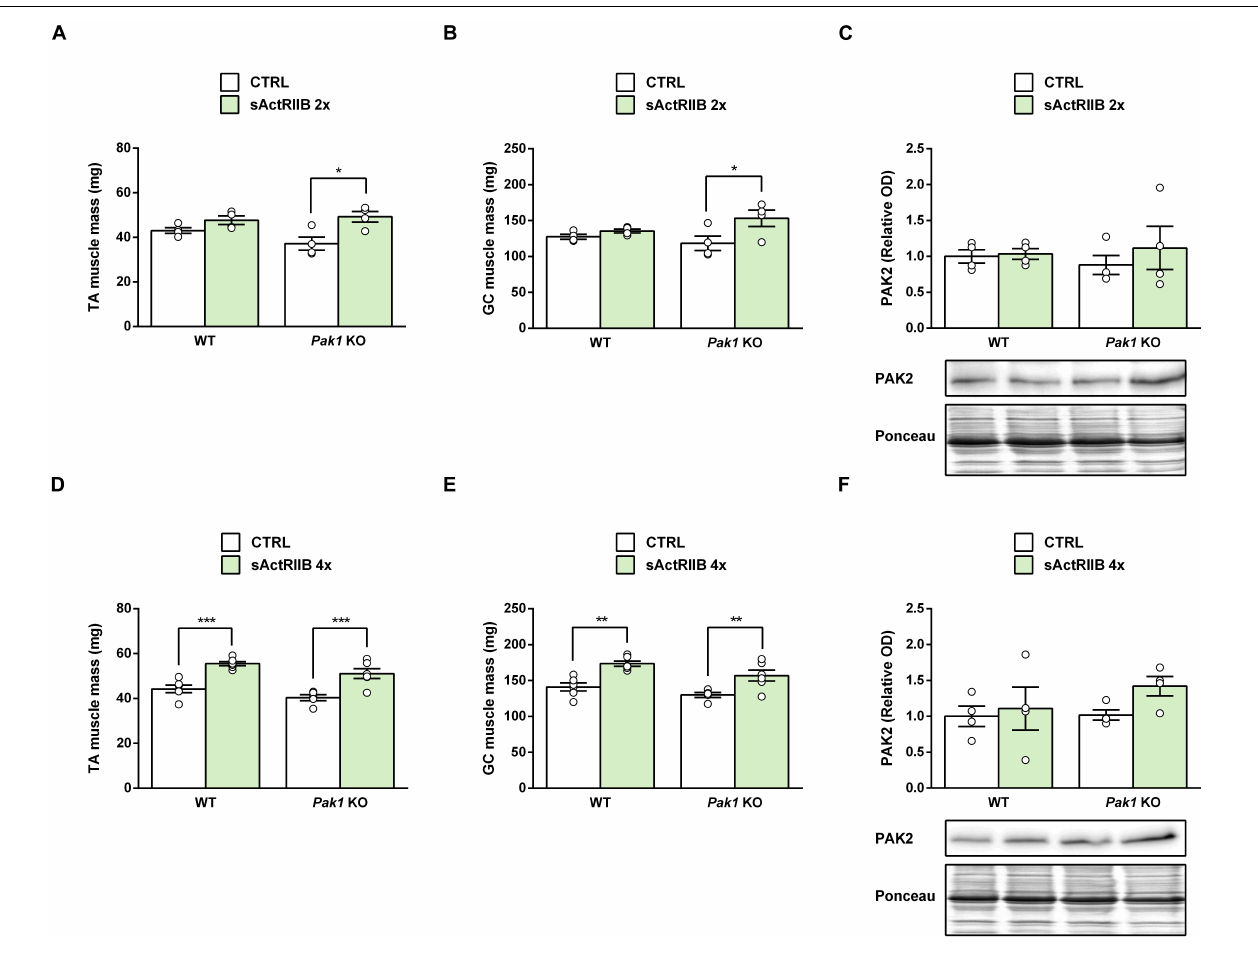
FIGURE 5 | sActRIIB induces skeletal muscle hypertrophy despite the absence of Pak1 . (A,D) TA and (B,E) GC muscle weight and (C,F) TA muscle PAK2 protein levels after 2 injections ( n = 4/group) or 4 injections ( n = 4–6/group) of sActRIIB (green columns) or PBS (white columns) in Pak1 KO vs. WT mice. Results are expressed as means ± SEM. Statistical analysis was performed using two-way ANOVA test and Bonferroni post-tests (sActRIIB effect: * P < 0.05; ** P < 0.01, and *** P <